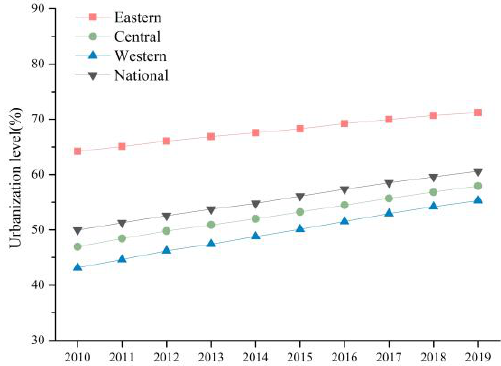
Figure 7. Changes in urbanization in China during 2010 – 2019.